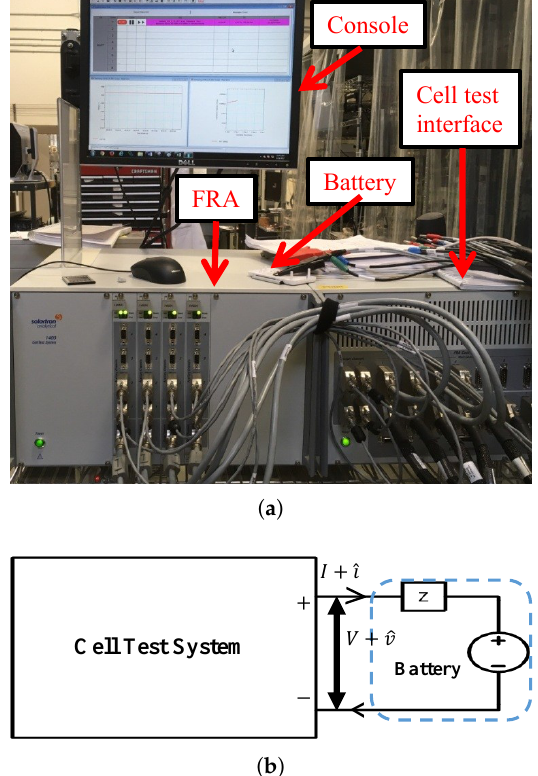
Figure 6. EIS experimental set up: ( a ) test bench; ( b ) block diagram.